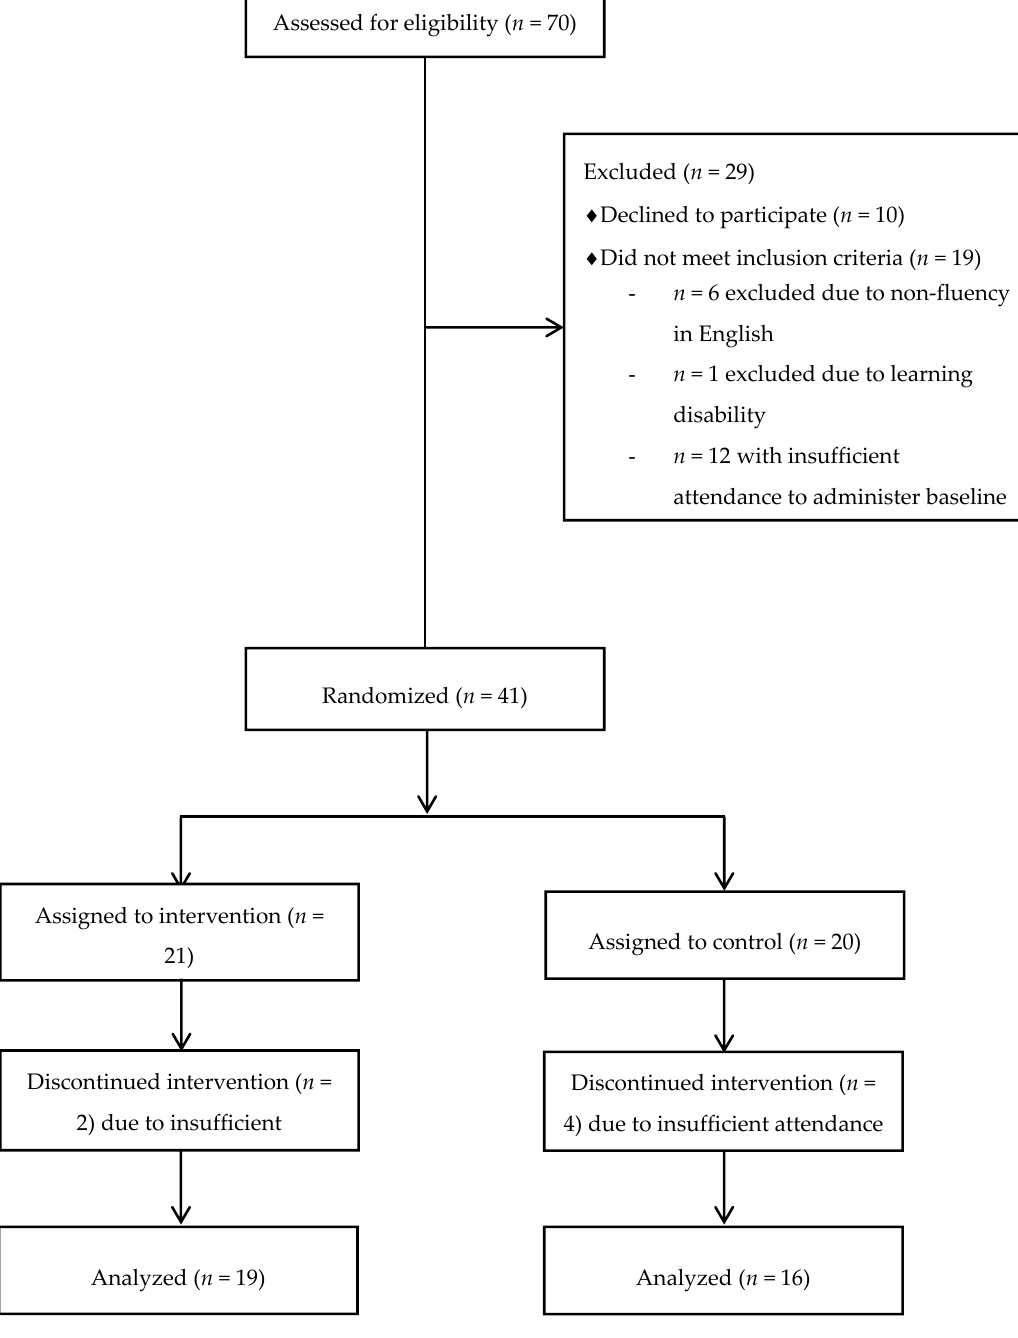
Figure 1. Participant Enrollment Flow Chart.